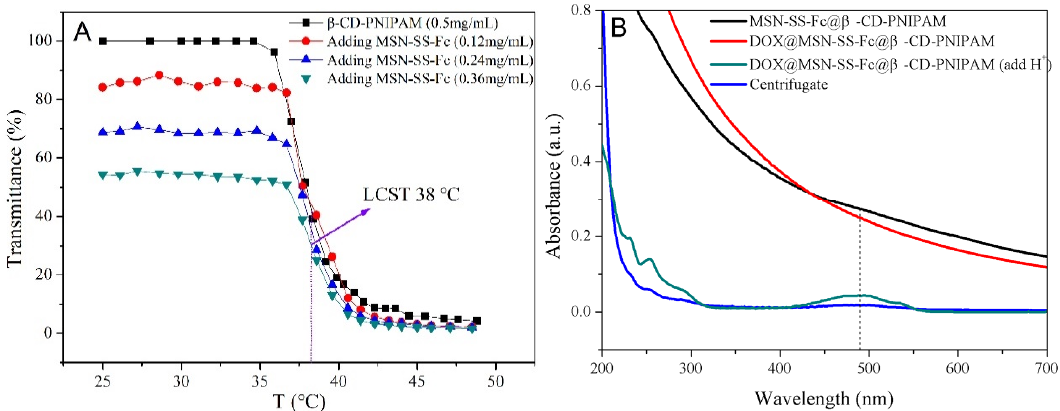
Figure 5. Transmittance of nanoparticles at di ff erent temperature (V β -CD-PNIPAM : V MSN-SS-Fc = 1:1) ( A ) and the UV–Vis absorption spectra of blank nanoparticles, DOX-loaded nanoparticles; DOX-loaded nanoparticles after adding H + and undergoing centrifugation (9.5 krpm, 20 min) in water ( B ).